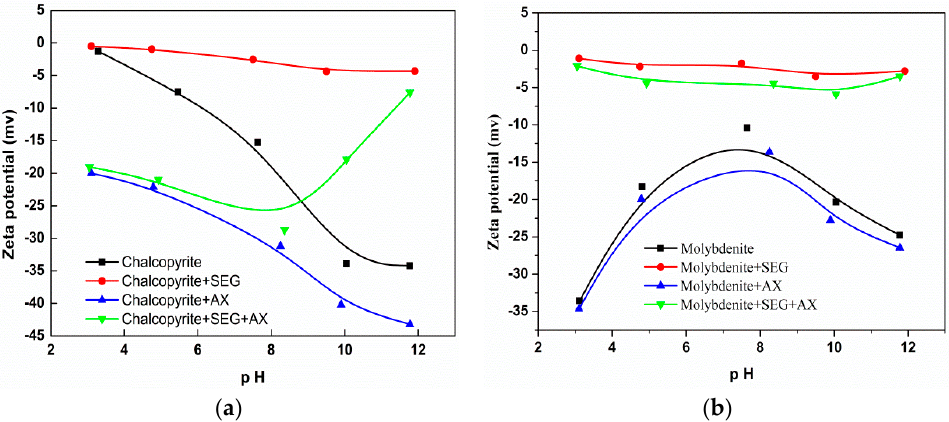
Figure 9. Zeta-potential of ( a ) chalcopyrite and ( b ) molybdenite in the absence and presence of SEG and AX under different pH conditions (SEG: 197 mg/L, AX: 16 mg/L).